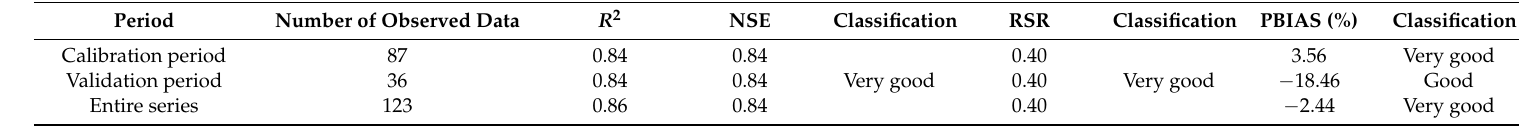
Table 3. Coefficients for assessing the model performance, according to Moriasi et al.